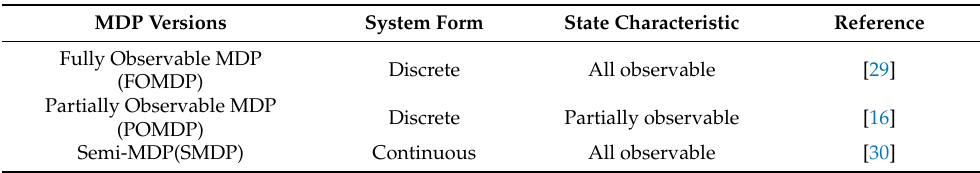
Table 2. Different versions of Markov decision